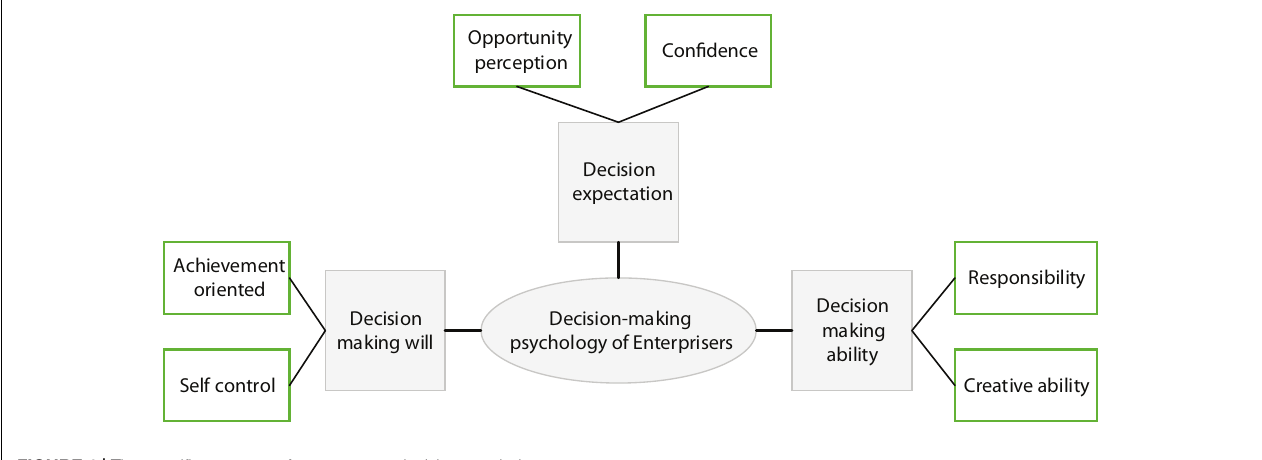
FIGURE 1 | The specific structure of entrepreneur decision psychology.